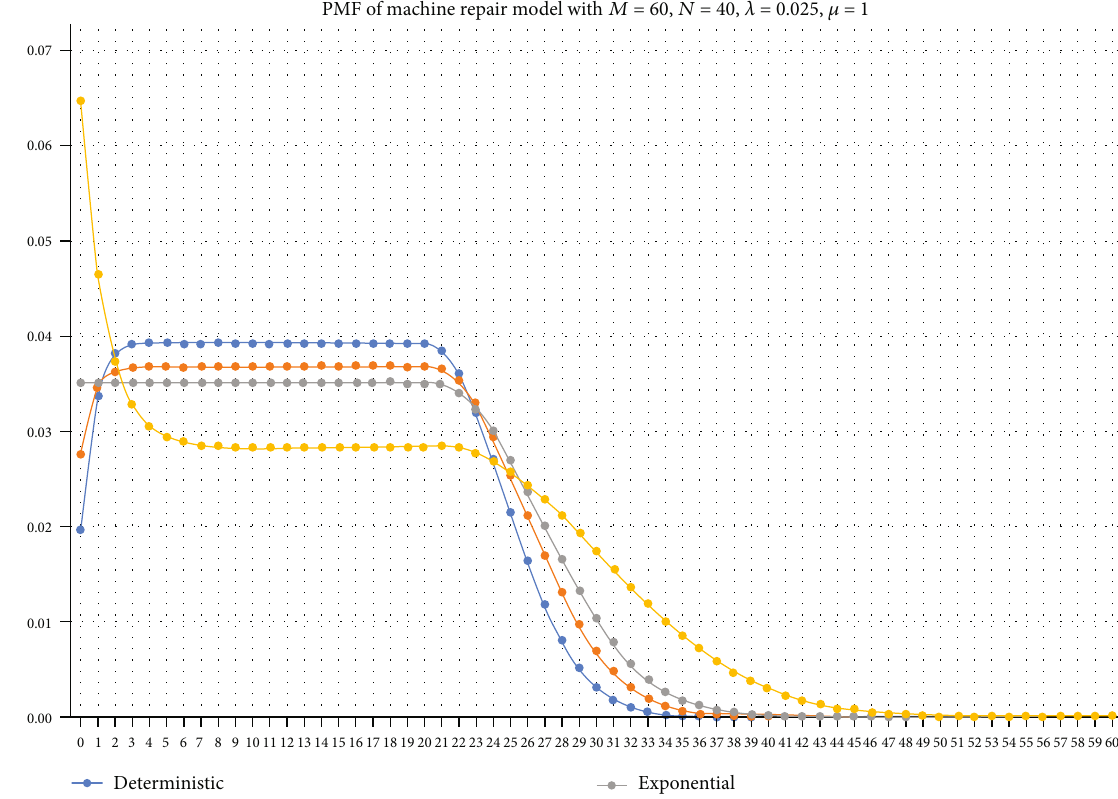
Figure 3: Probability mass